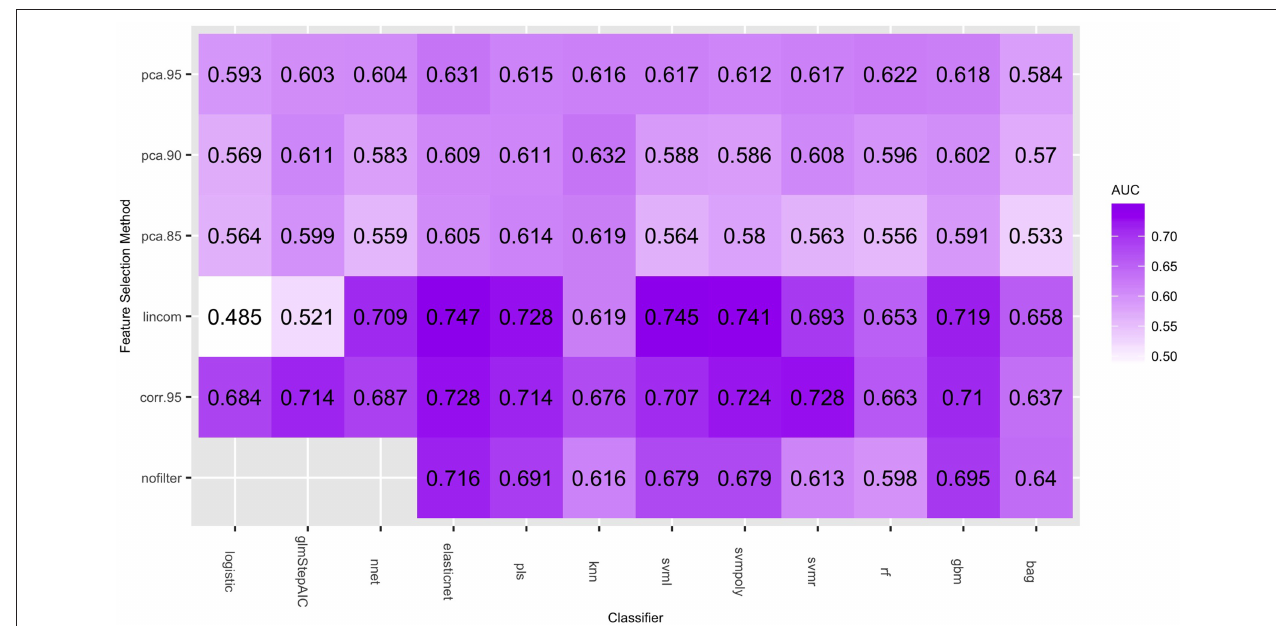
FIGURE 1 | Average AUC values (over the 50 repeated cross-validation testing sets) of each feature selection/classifier combination.